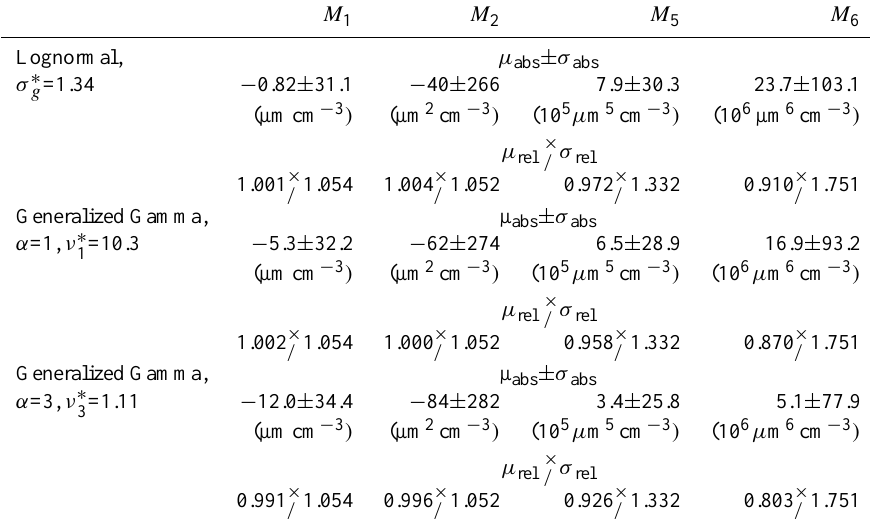
for the GG1 and ν ∗ for the GG3. 1 3